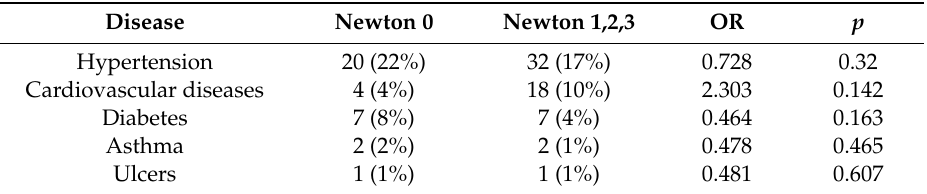
Table 3. The health of the patients who became eligible for antifungal pharmacotherapy in group Newton 0 and Newton 1, 2 or